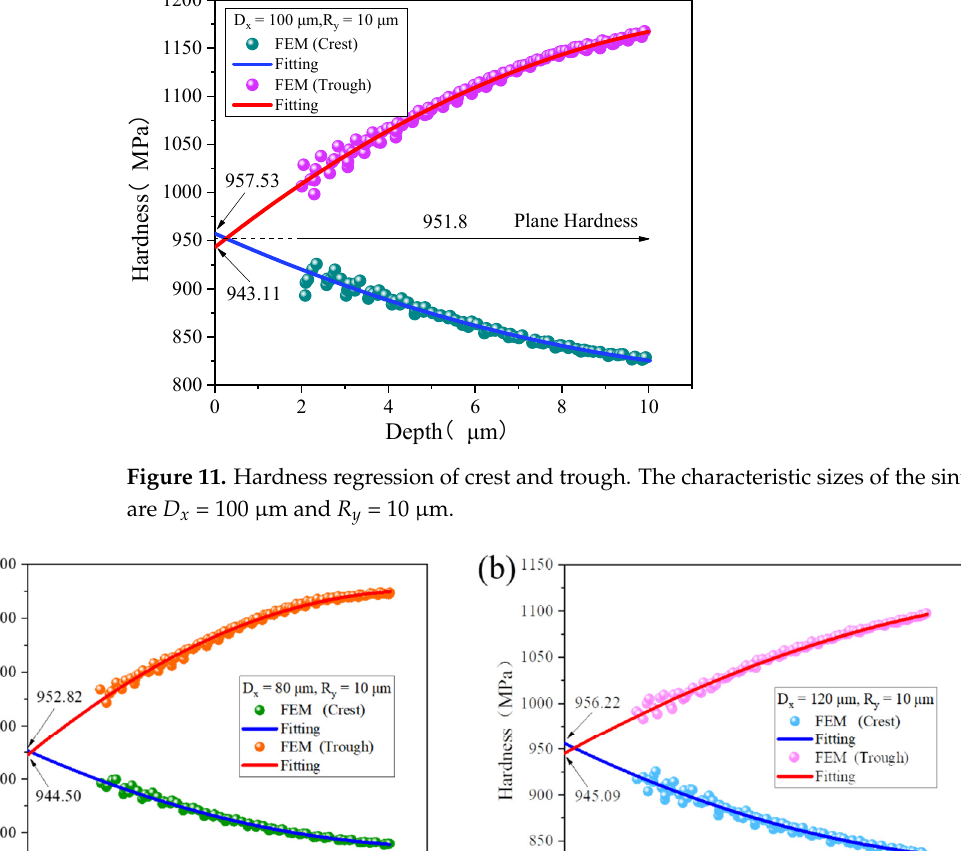
Figure 11. Hardness regression of crest and trough. The characteristic sizes of the sinusoidal surface are D x = 100 μm and R y = 10 μm.